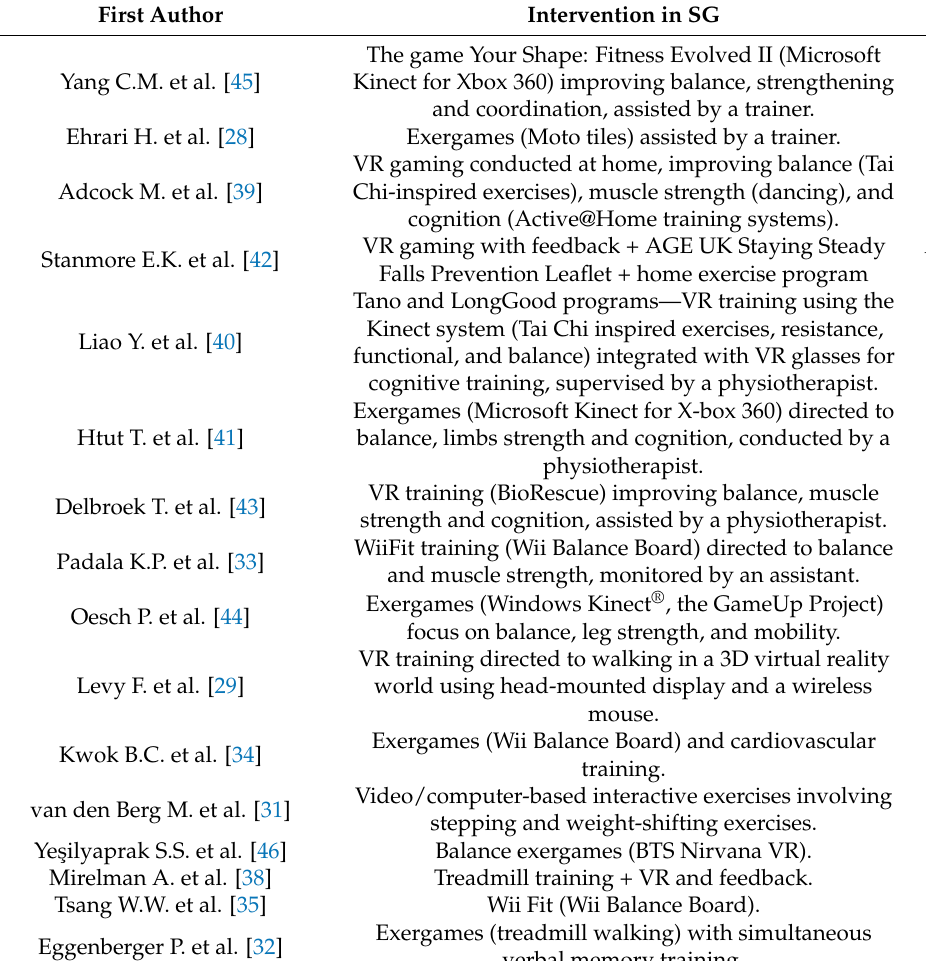
Table 1. Characteristics of intervention used in included